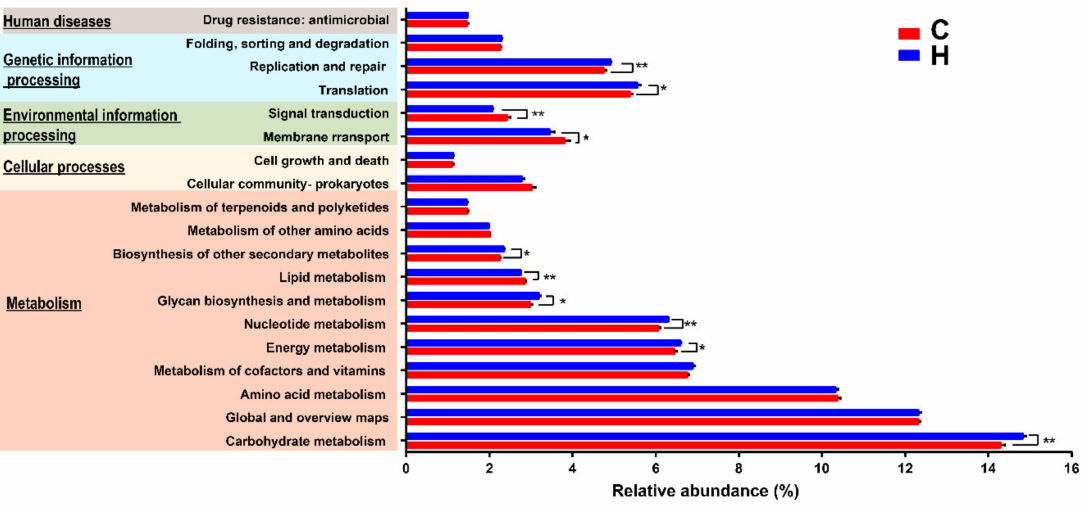
Figure 3. Di ff erences in bacterial metabolism function at KEGG level 2 between Groups C and H using PICRUSt2.